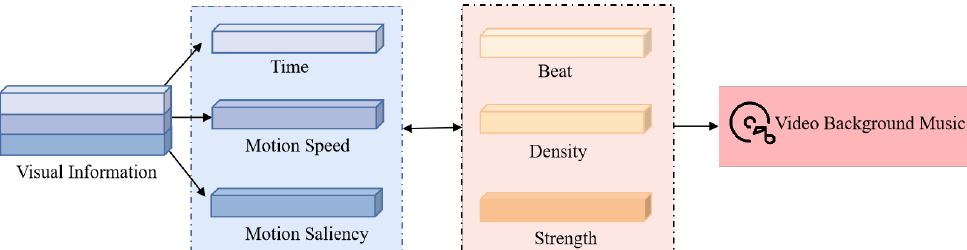
Figure 4. The connection of visual and